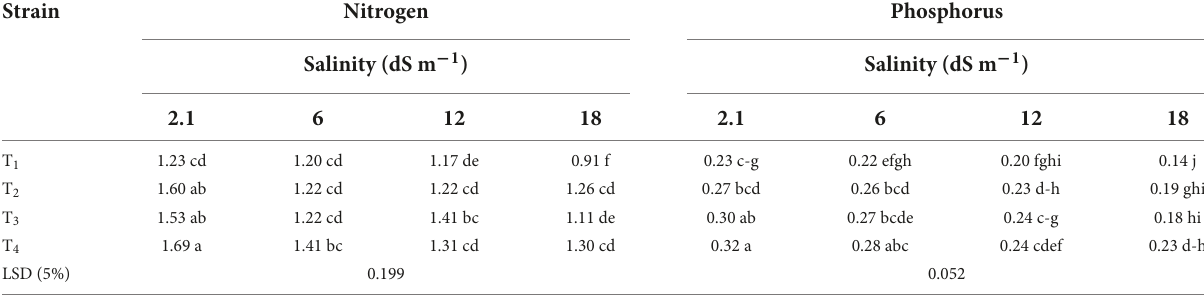
TABLE 9 Effect of inoculation with multi-strain bacterial consortium on nitrogen and phosphorus content (%) of wheat grain at different salinity levels in a pot trial.